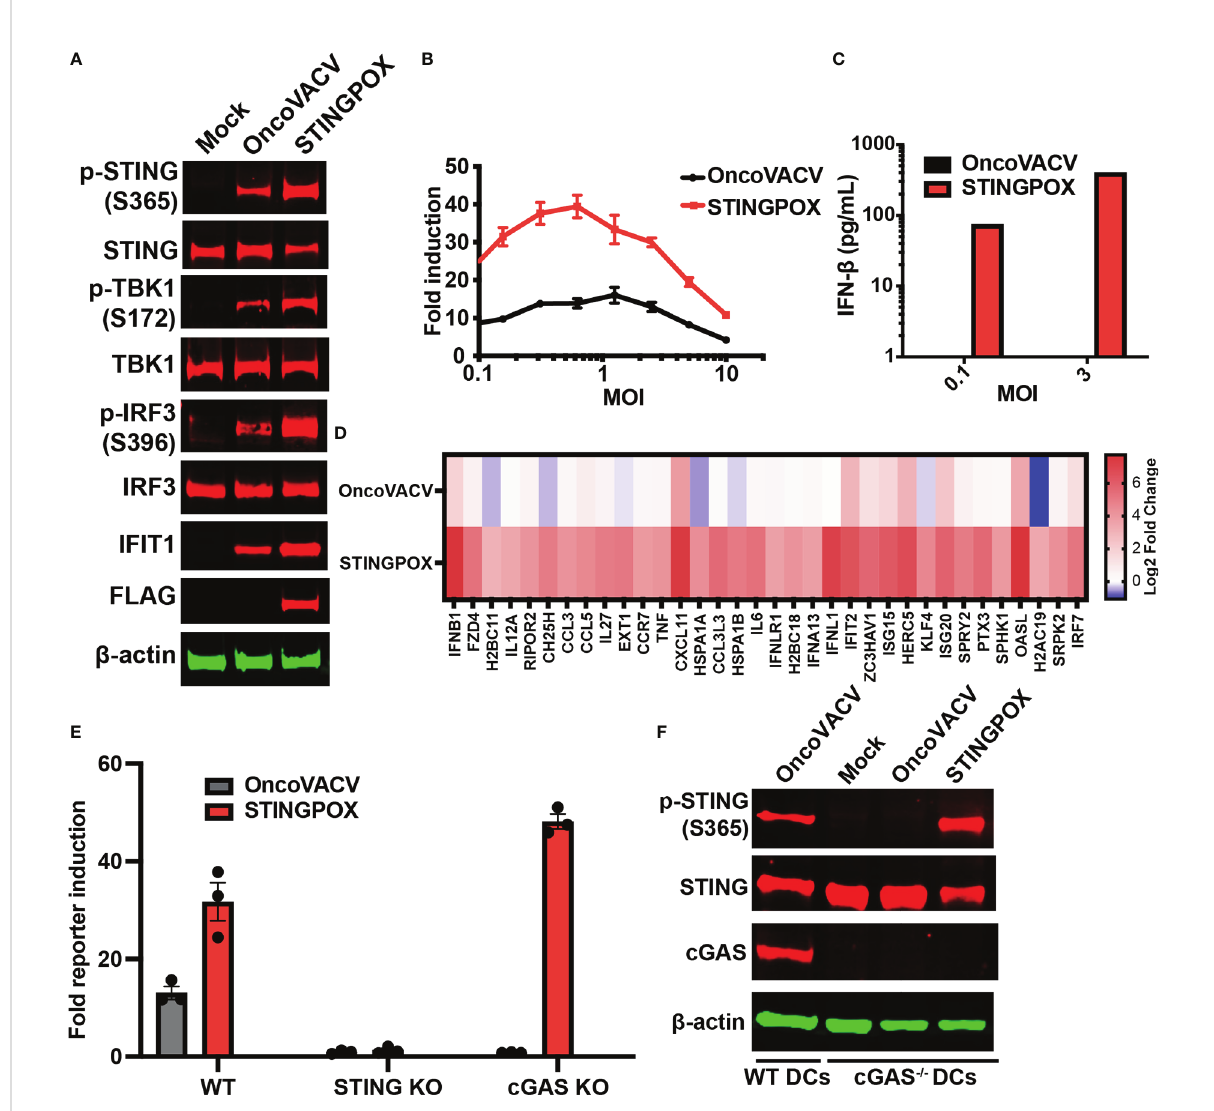
FIGURE 4 STINGPOX induces IFN signaling in a STING-dependent manner. (A) Primary murine BMDCs were infected with STINGPOX or OncoVACV for 24 h. Whole cell lysates were analyzed by WB for phospho-STING (p-STING S365), STING, phospho-TBK1 (p-TBK1 S172), TBK1, phospho-IRF3 (p-IRF3 S396), IRF3, IFIT1, cGAS and FLAG (for disA expression). b -actin levels were used as loading control. Data are representative of three independent experiments. (B) THP1-Dual cells were infected with STINGPOX or OncoVACV (at a range of MOIs) and relative luciferase activity was assessed as a measure of IFN signaling (n = 3). (C) Supernatants IFN- b levels in THP1-Dual infected with STINGPOX or OncoVACV (MOI of 0.3 or 1) for 24 h were measured by ELISA. (D) Heatmap of relative fold change in expression (to mock) in primary human macrophages infected with OncoVACV or STINGPOX (MOI = 3) for 18 hours, and analyzed by RNA-seq. Log2 transformed data is shown for genes associated Jak/STAT or IFN ab signaling pathways that were activated at least 4-fold in STINGPOX infected cells relative to OncoVACV infection conditions. (E) IFN signaling measured as described in (B) using WT, cGAS KO, and STING KO THP1-Dual cells. (F) Immunoblot analyses of primary murine WT and cGAS -/- BMDCs infected with STINGPOX or OncoVACV, as described in (A) . Data are shown as mean ±